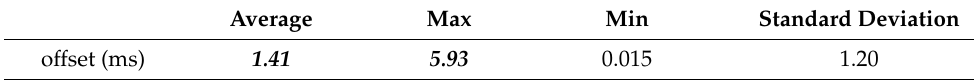
Table 3. Time delay between NTPServer and PC using